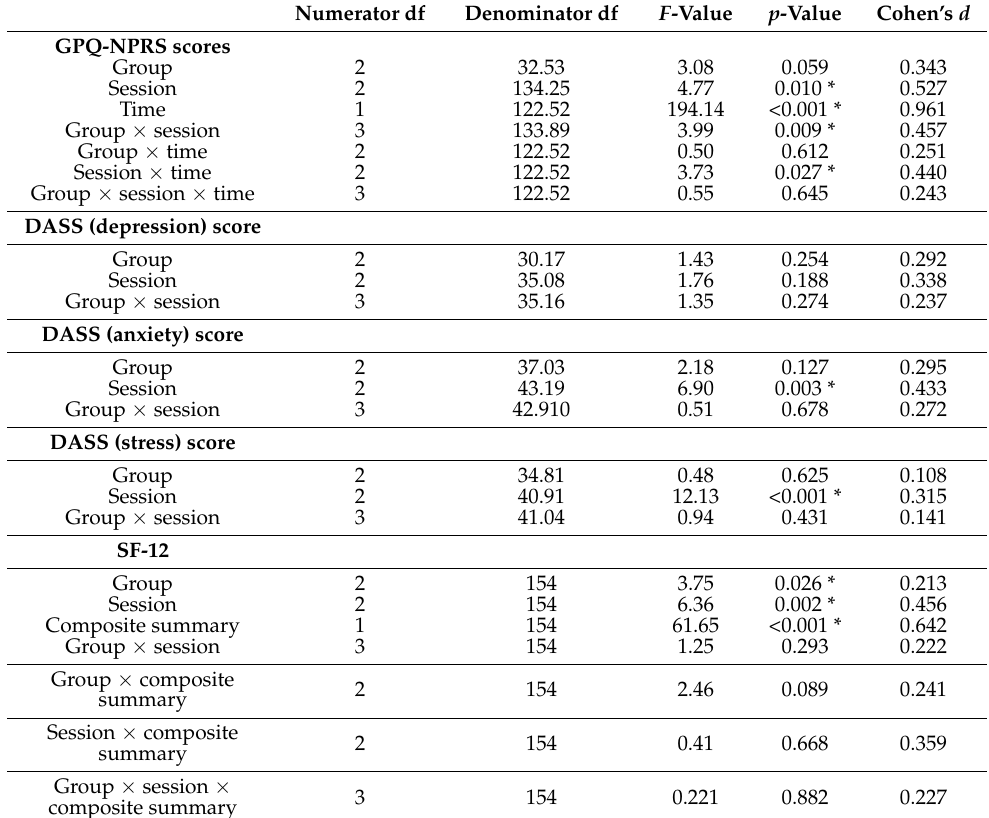
Table 2. Results of the linear mixed models (LMM) performed for the GPQ-NPRS, DASS, and SF-12